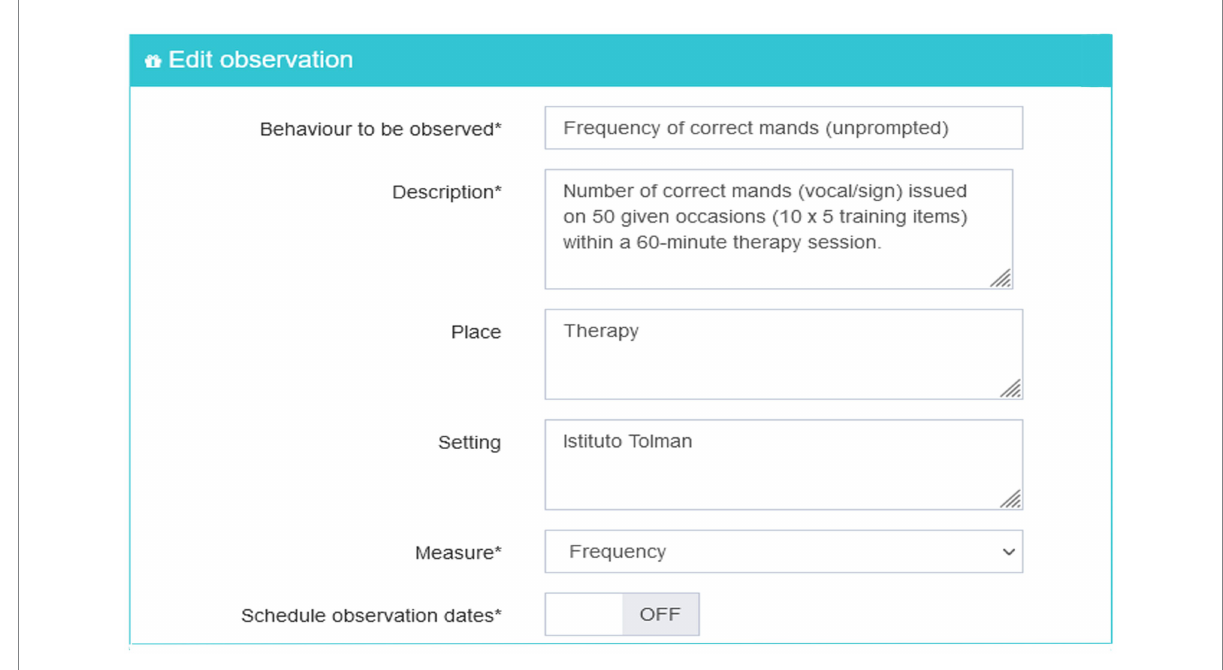
FIGURE 1 Screenshot of the target behaviors form of the BEHAVE